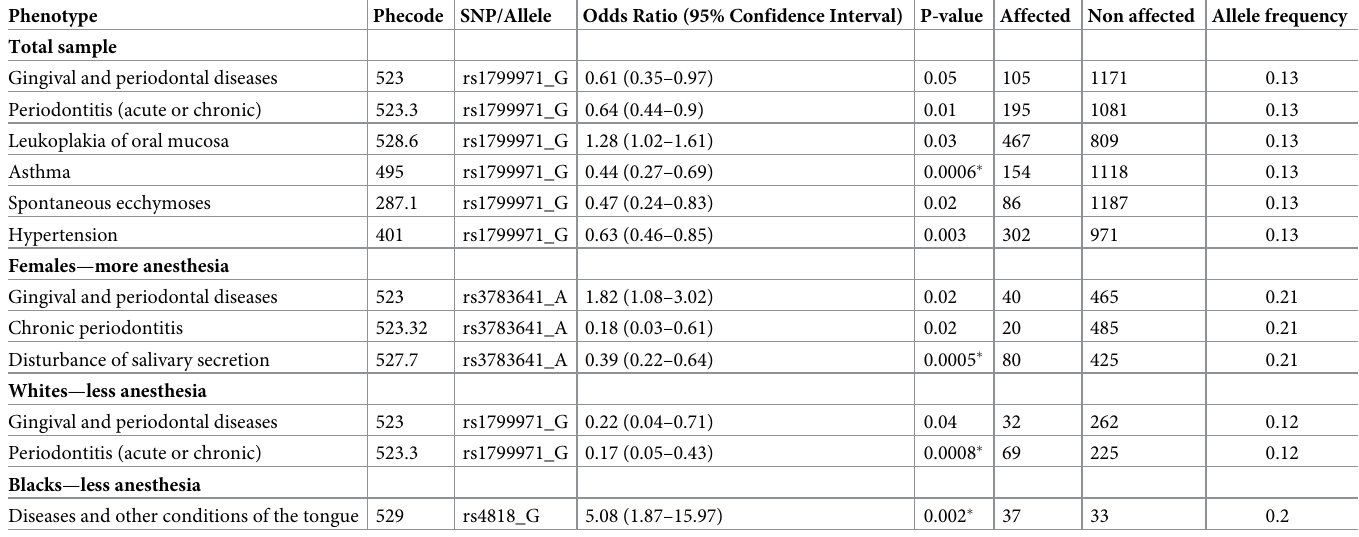
Table 4. Summary of the PheWAS results of p-values below 0.05 for each SNP separately, using the total sample, and the groups that received more and less anes- thesia, considering sex and ethnicity. � Indicates statistically significant results after correction for multiple testing.